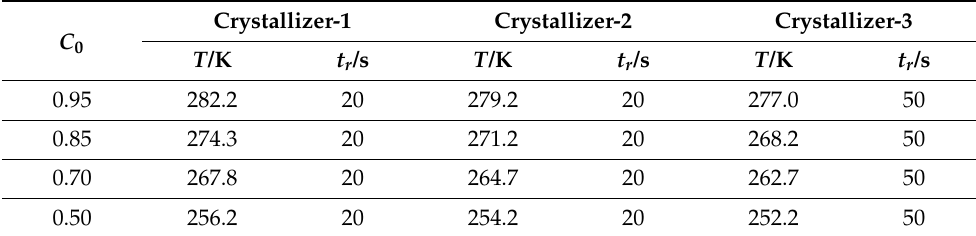
Figure 6. The experimental setup for the three-stage MSMPR crystallization process. Table 3. The experimental temperatures and residence time in each crystallizer. C 0 : the PX con- centration in feed, and OX: MX = 0.3; T : the operating temperature, K; t r : the mean residence time,